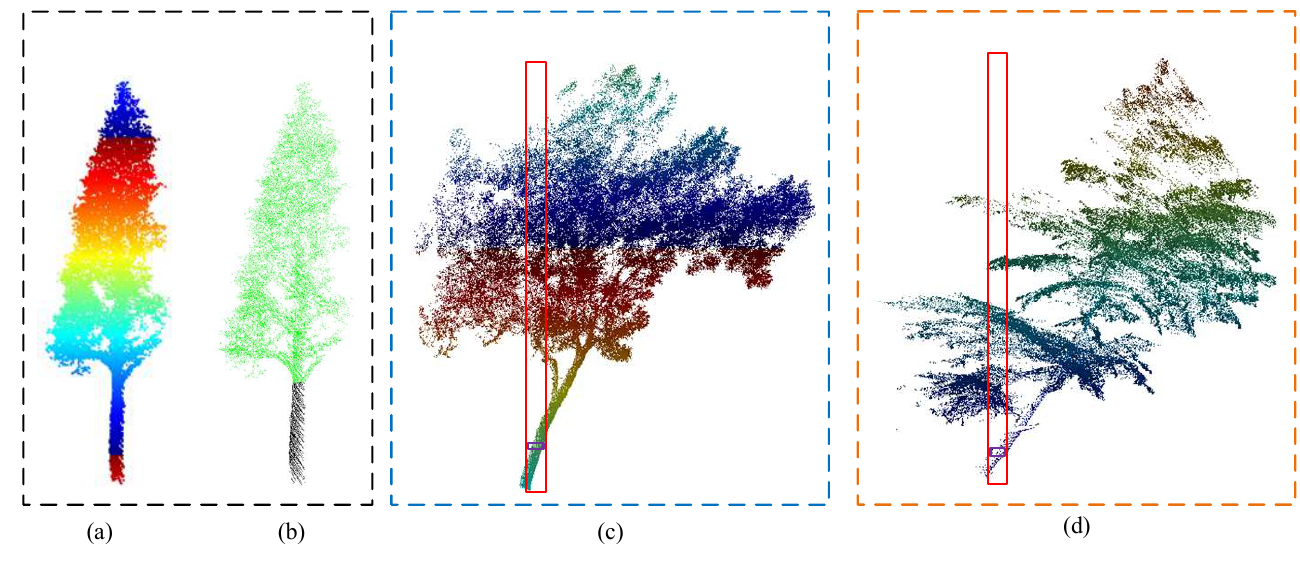
Figure 18. Mis-segmentation cases: ( a ) Manual denoising of Figure 12c; ( b ) The effect of trunk extraction; ( c ) Circle segmentation results of Figure 13c; ( d ) Circle segmentation results of Figure 15d. (The purple rectangles indicate the acquired reference slices and the red rectangles indicate the circle segmentation results in ( c , d ).